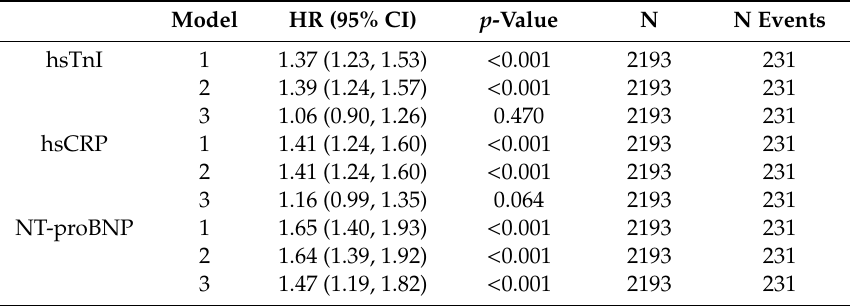
Table 3. Association of circulating biomarkers with cardiovascular death and / or MI during follow-up. The hazard ratios (HRs) are per standard deviation.